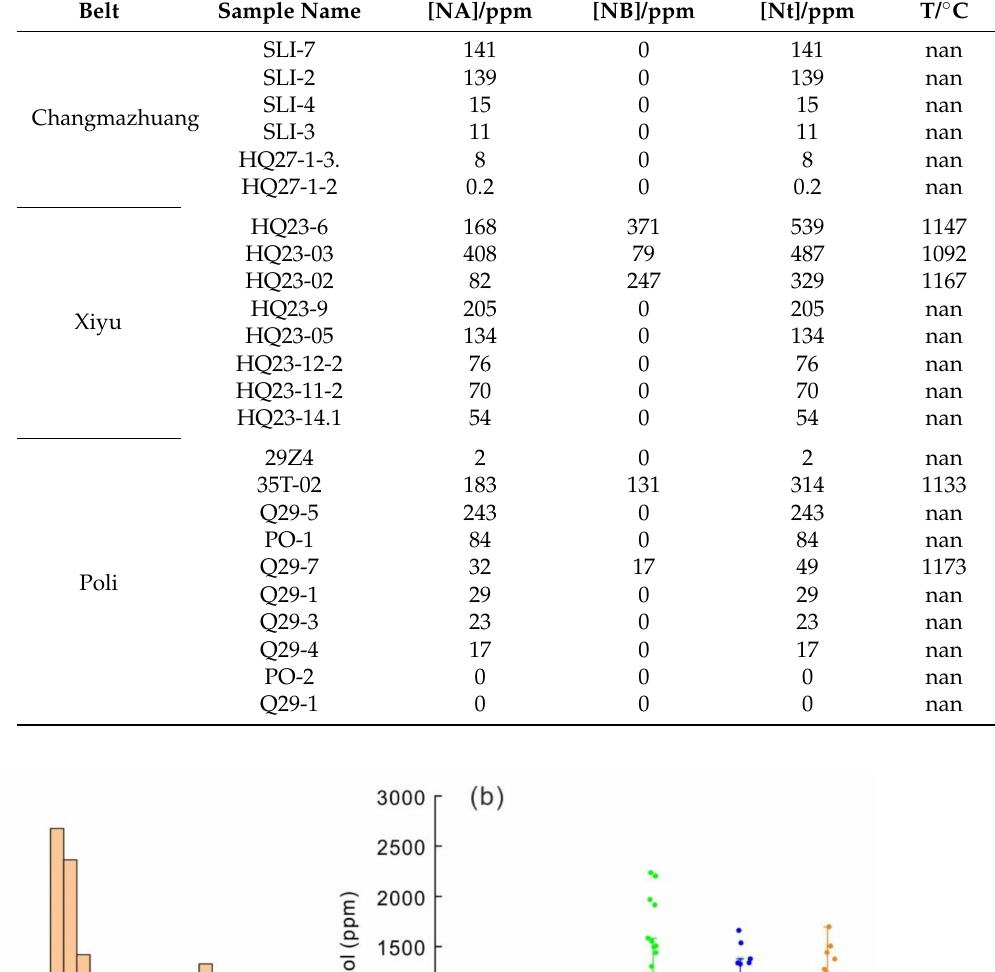
Table 2. N contents and formation temperature of diamonds in three belts calculated by software QUIDDIT. [NA], [NB], [Nt] mean concentration of nitrogen in A, B center and total nitrogen content, respectively.